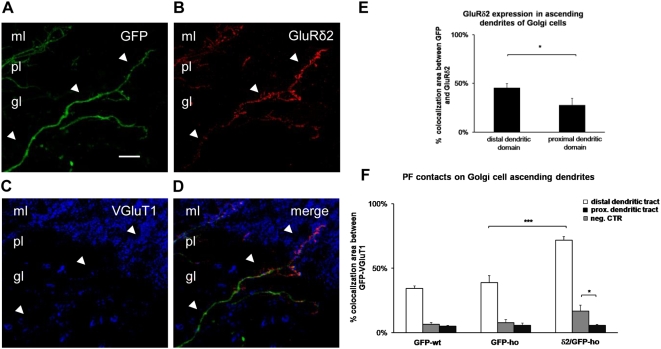
Difference in the distribution of PF contacts along the ascending domain of Golgi cell expressing GluRδ2.(A–D) Immunostaining of the ascending dendritic tract of a Golgi cell (green, A) characterized by differential localization of GluRδ2 (arrowheads) (red, B) and relative VGluT1 (blue, C) signals (D, merge). GluRδ2 expression gradually increases in the proximal domain (gl) at the level of the PC layer (pl), reaching high levels in the distal tract (ml). Although the expression of GluRδ2 is less prominent in the proximal domain, the area that is in contact with the PF inputs is significantly increased relative to both the control groups and the negative control. (E) Histogram shows the mean percentage of the GFP area that colocalizes with GluRδ2 in Golgi cell dendrites of GFP/δ2 mice. A significant reduction of GluRδ2 expression in the proximal tract is observed. (F) Histogram shows the mean percentage of the GFP area that colocalizes with VGluT1 in Golgi cells of GFP-wt, GFP-ho, and δ2/GFP-ho mice. The white columns represent the value obtained in the distal dendritic domain; the light gray columns are the value in the proximal dendritic tract; and the dark gray columns are the negative control value of colocalized GFP-VGluT1 in the rosette. The ectopic expression of GluRδ2 induces a significant increase in PF contacts in both layers. * p<0.05; ***p<0.001. Error bars indicate SE. Scale bar A–D: 10 µm.